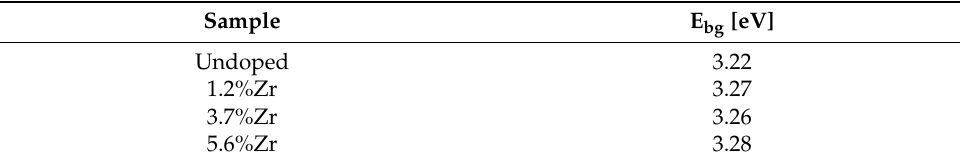
Table 6. Indirect energy bandgap values extracted from Tauc’s plots.